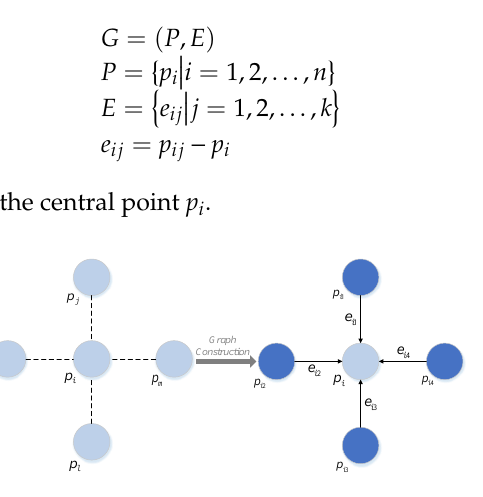
Figure 5. Graph construction of a point cloud. The p i , p j , p k , p l , p m are the points in the point cloud. (cid:8) (cid:9) p i 1 , ... , p i 4 The p j , p k , p l , p m on the left and on the right are the nearest neighbors of p i . The directed edges { e i 1 , ... , e i 4 } are the edges from the neighbors to the central point.